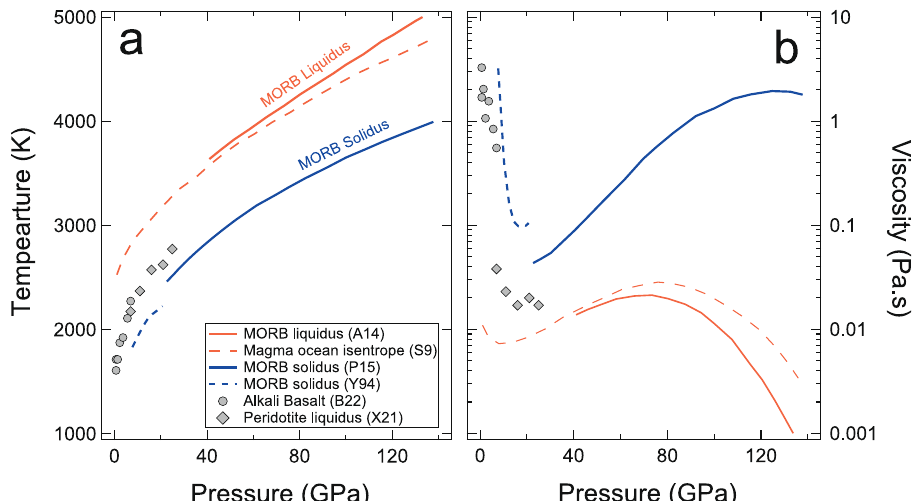
Fig. 4 | Temperature and viscosity of magma ocean. a Temperature pro fi les showing a magma ocean isentrope:S9 (orange dashed lines) 73 , liquidus (orange solid lines) 71 , and the solidus (solid and dashed blue lines) 78,79 of mid-oceanic ridge basalt (MORB). b The predicted viscosity of model basaltic melts using the